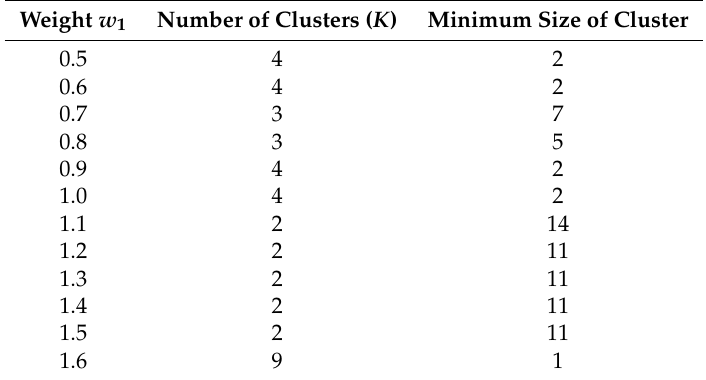
Table 2. The table summarizes the results of the total number of clusters and the minimum size of clusters within each clustering for different weight values